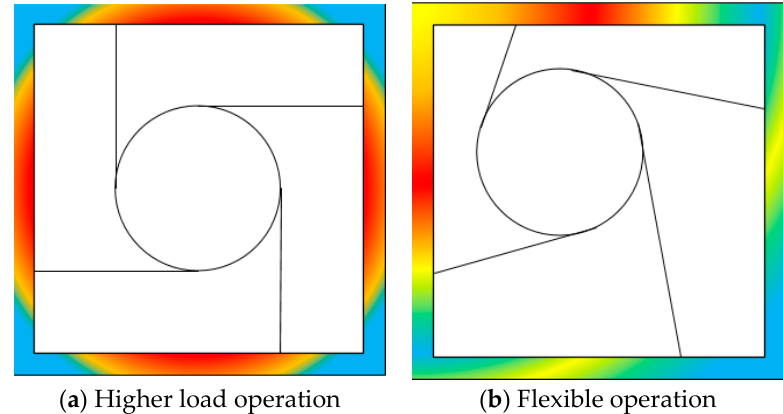
Figure 8. Heat flux distribution comparison between high load and flexible operation at the four sidewalls.